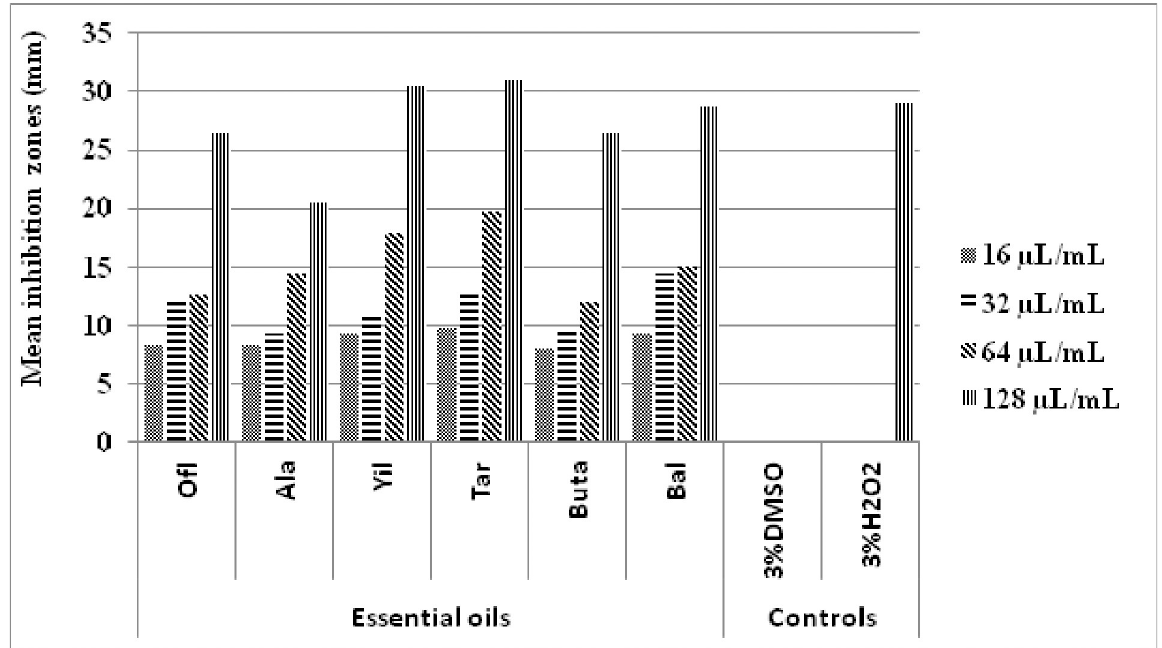
Fig 1. Inhibition of Lactobacillus by EOs from six localities with doses ranging from 16 μ l/mL to 128 μ l/mL in comparison with the negative and positive controls.